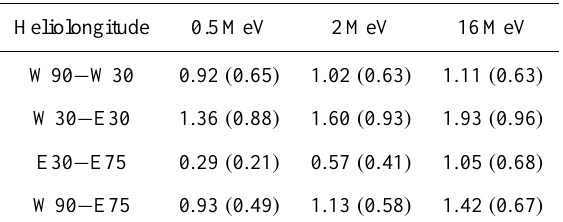
Fig. 2. Variation of the 1MeV proton peak flux as a function of the initial shock speed and the heliolongitude of the observers located at 1 AU. The 14 heliolongitudes are color coded from top (higher peak flux values) to bottom (lower values) as indicated. To make the plot clear, the lines have been binned in three traces: dashed lines for western events (from W90 to W45), solid lines for cen- tral meridian events (from W30 to E30) and dotted lines for eastern events (from E45 to E75). These values of the peak flux are the av- eraged value of the peak intensity of the flux profiles corresponding to the four transport conditions, decribed by variables [4] and [5], for each initial shock speed and heliolongitude. Table 1. Values derived for the correlation coefficient between f and v, at 1 AU, for three energies of the particles, as a function of the heliolongitude of the observer’s location. Each row shows the values of α and the coefficient of correlation, r, of the fit, for western, central meridian and eastern SEP events. The fourth row shows the corresponding values derived from the fit of the whole set of heliolongitudes.